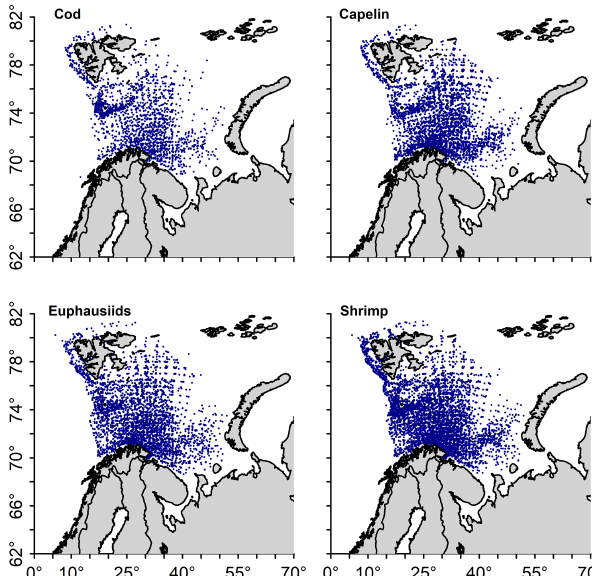
Figure 7. The presence of the main prey species in stomachs over all years combined. Each dot denotes a stomach